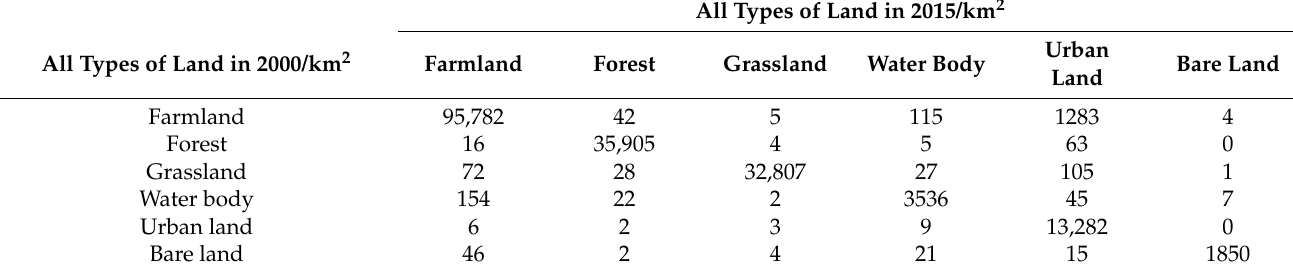
Table 5. Land-use transfer matrix of Hebei from 2000–2015. All Types of Land in 2015/km 2